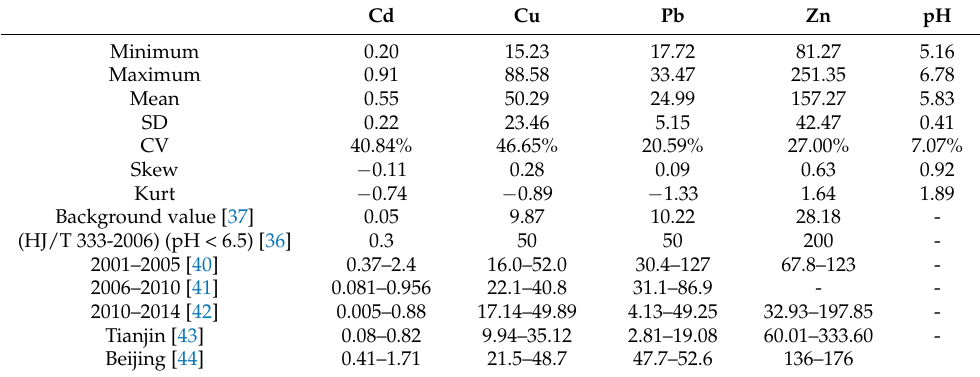
Table 2. Descriptive statistics of the heavy metals and pH in the soil of the study area ( n = 12, mg · kg − 1 ). Cd Cu Pb Zn pH